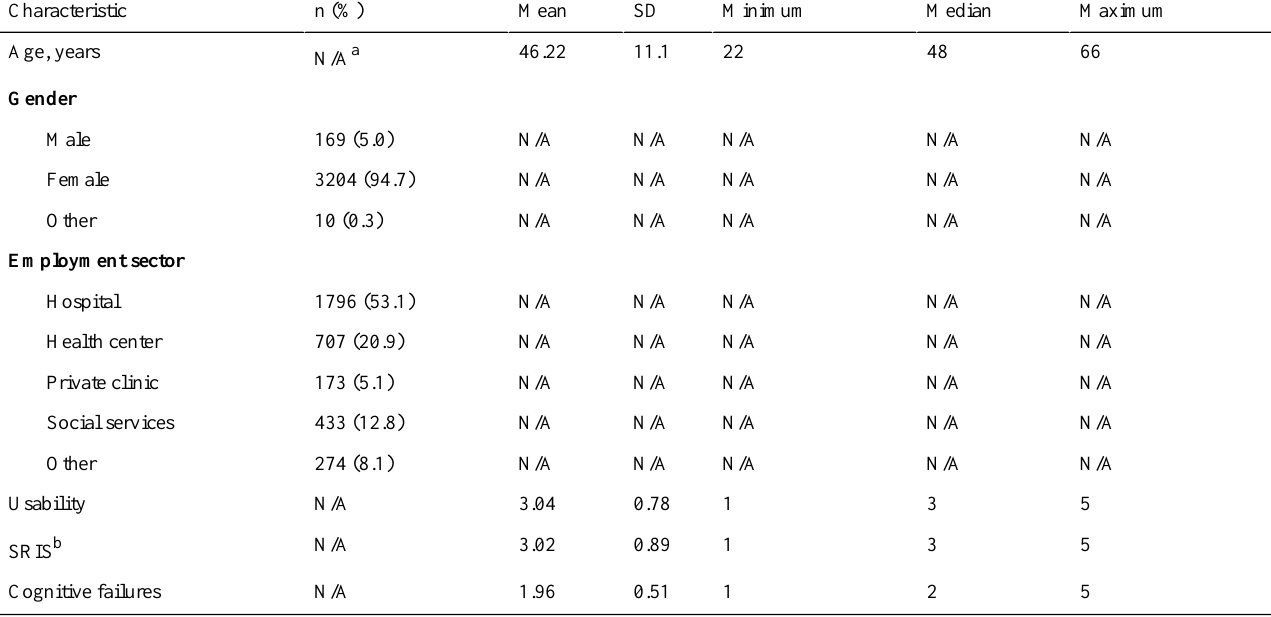
Table 1. Characteristics of the participants (N=3383) and descriptive